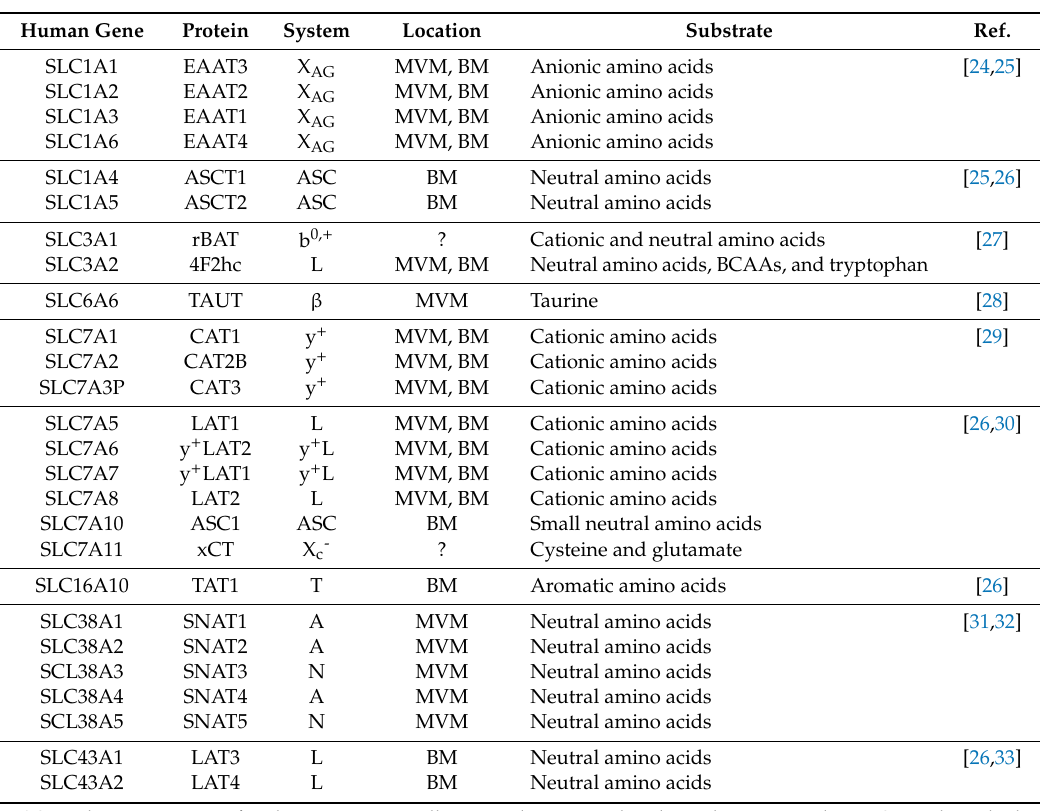
Table 1. Amino acid transporter systems in the human